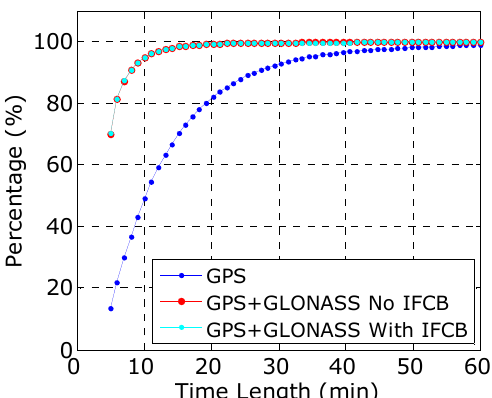
Figure 8. Fixing percentage with various observation durations for kinematic PPP with different strategies. Receivers with homogeneous type are used as rover sites. Table 2. Fixing percentage with various observation durations for kinematic PPP with different strategies.